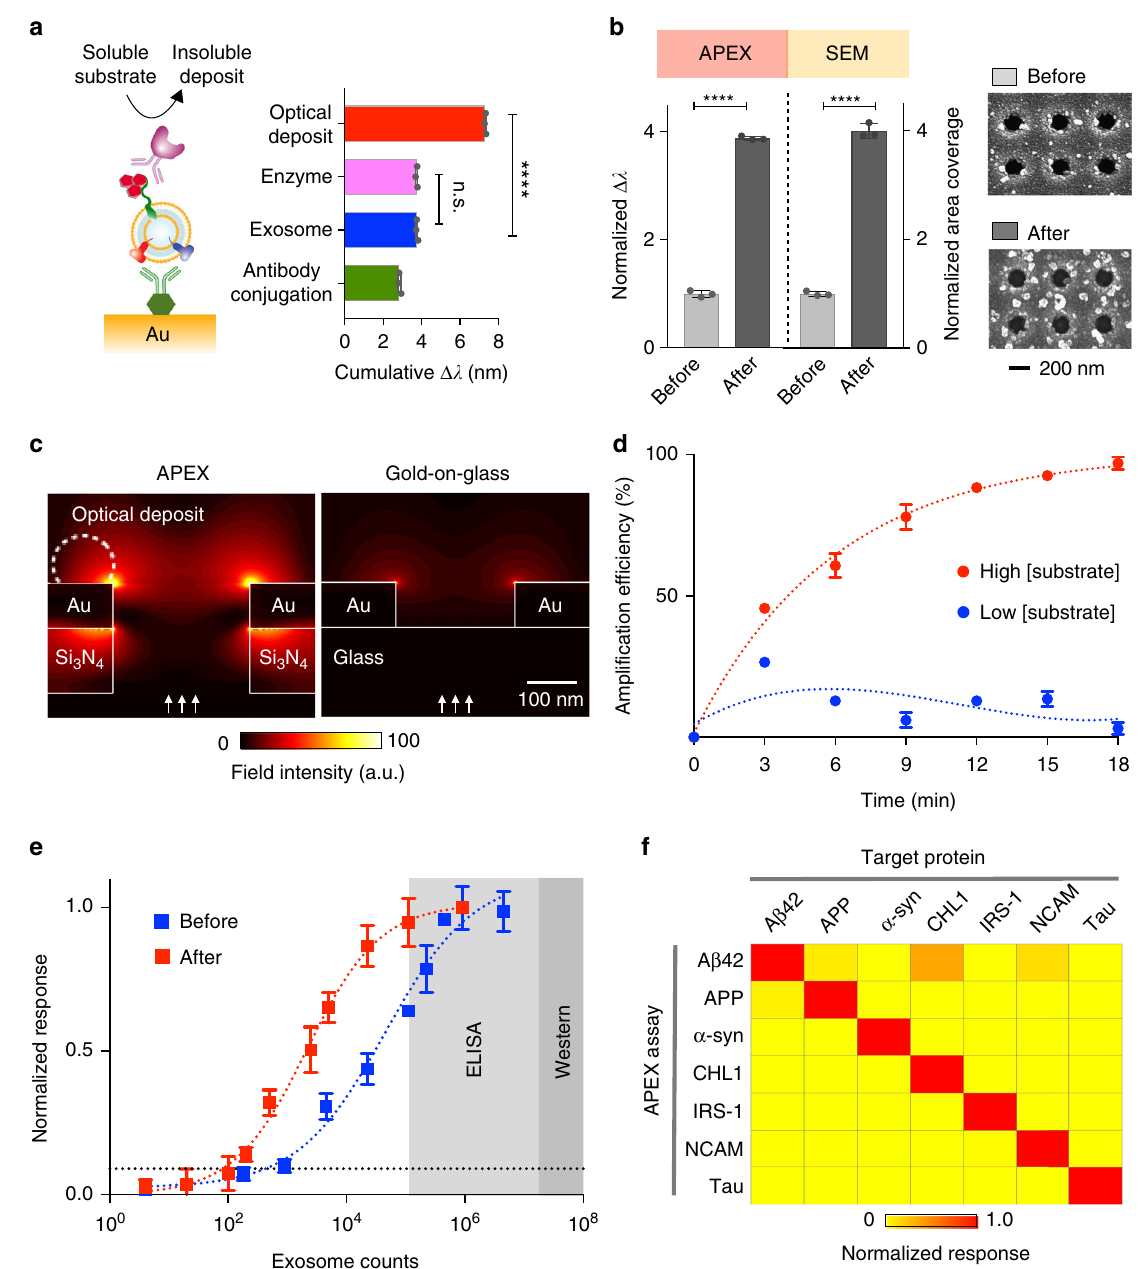
Fig. 2 APEX signal ampli fi cation and multiplexed pro fi ling. a Step-by-step APEX transmission spectral changes. We performed a series of operations, namely antibody conjugation (anti-CD63) onto the sensor, exosome binding, enzyme labeling and enzymatic deposition, and monitored the resultant spectral shifts. While the enzyme labeling did not cause any signi fi cant changes, the deposit formation led to ~400% signal enhancement (**** P < 0.0001, n.s. not signi fi cant, Student ’ s t- test). b Comparison of APEX signal ampli fi cation and optical deposit area coverage. The increase in area coverage was determined by scanning electron microscopy (SEM) analysis (**** P < 0.0001, Student ’ s t- test). All data were normalized to that before the signal ampli fi cation. Inserts (right) show SEM images of sensor-bound exosomes, before and after APEX ampli fi cation. c Finite-difference time-domain simulations with back illumination. The APEX sensor design, but not the gold-on-glass design, enables the generation of enhanced electromagnetic fi elds through back illumination. Back illumination minimizes direct incident light exposure on the enzyme activity (which occurs on the sensor ’ s top surface). Arrows indicate the direction of incident illumination. d Real-time sensorgrams of APEX ampli fi cation kinetics. Different concentrations of the optical substrate (3,3 ′ -diaminobenzidine tetrahydrochloride; high: 1 mg ml − 1 , low: 0.01 mg ml − 1 ) were used to monitor the ampli fi cation ef fi ciency. All data were normalized against negative controls, performed with IgG isotype control antibodies. e Comparison of the detection sensitivities of APEX, ELISA, and western blotting. The APEX detection limit (dotted line), before and after ampli fi cation, was determined by titrating a known quantity of exosomes and measuring their CD63 signal. f Speci fi city of APEX assays for measuring target proteins. Assays were developed for amyloid β (A β 42), amyloid precursor protein (APP), alpha-synuclein ( α -syn), close homolog of L1 (CHL1), insulin receptor substrate 1 (IRS-1), neural cell adhesion molecule (NCAM), and tau protein. All assays demonstrated speci fi c detection. Heat map signals were assay (row) normalized. All measurements were performed in triplicate, and the data are displayed as mean ± s.d. in ( a , b , d , and e ). Source data are provided as a Source Data fi